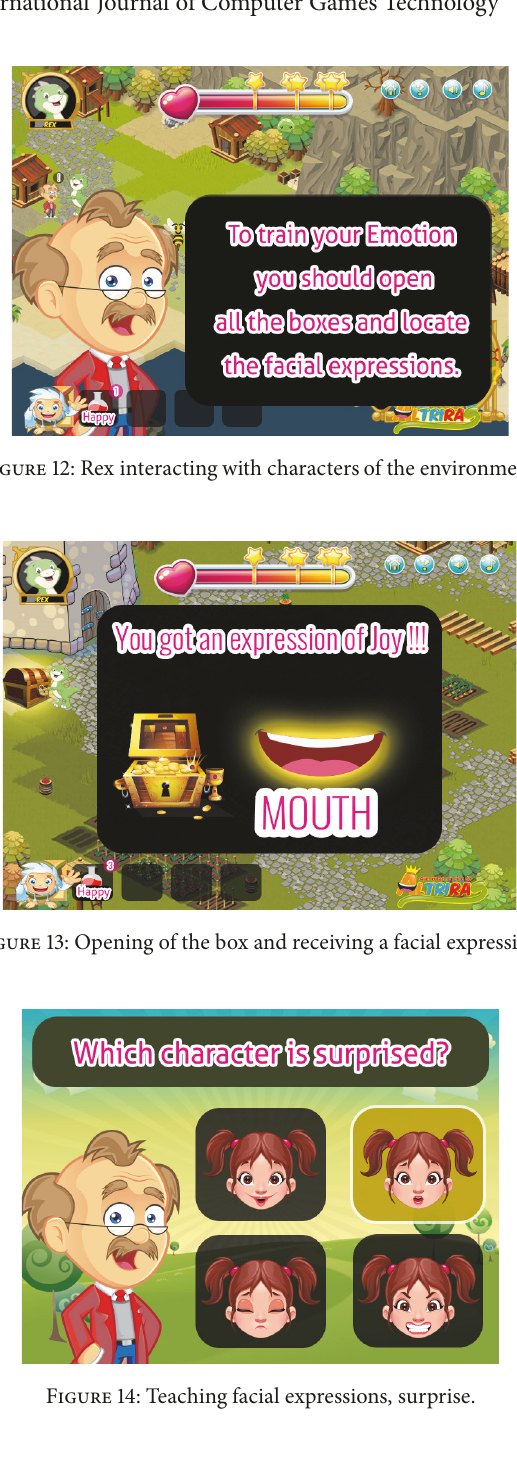
them are considered as “Great” (5%), “Good” (15%), and “ok” (5%).